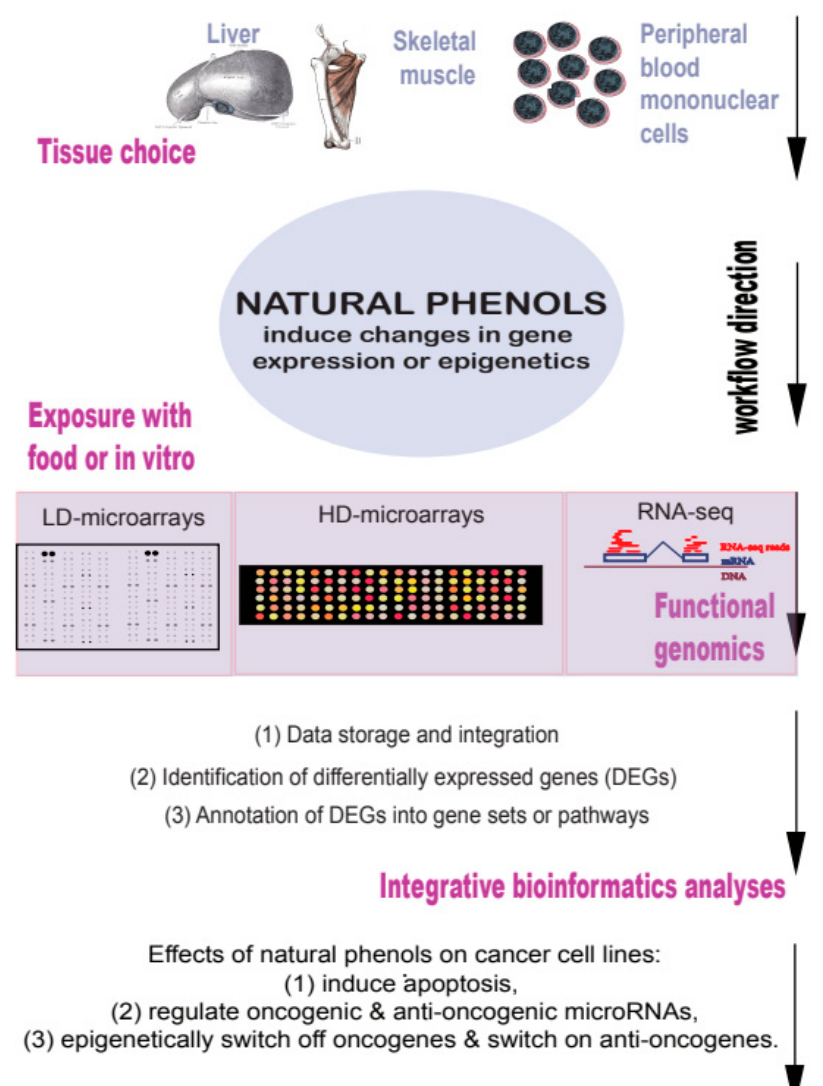
Figure 2. Natural phenols induce complex gene expression changes that can be studied using func- tional genomics and anti-reductionist bioinformatics. functional genomics and anti-reductionist